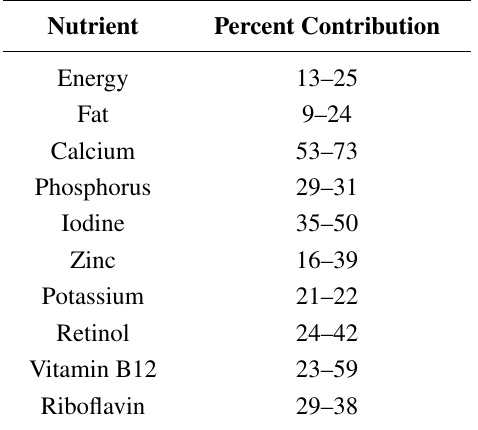
Figure 1. Calcium intake in different countries (animal calcium is provided mainly by dairy products). Note: this information does not include recent changes in dairy consumption in East Asian countries. The calcium intake, due to lack of milk intake, in many African countries is very low in comparison to requirements (see text). Table 8. Percent contribution of dairy products (milk, milk drinks, yogurts, cheeses, and dairy desserts) to key nutrient intakes in children and adolescents in developed countries *. Nutrient